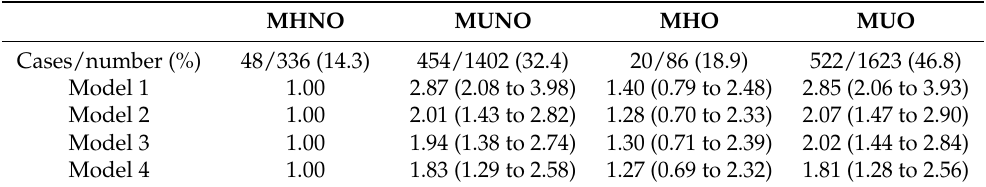
Table 2. Multifactorial logistic regression analyses for carotid plaque according to the obesity phenotypes.